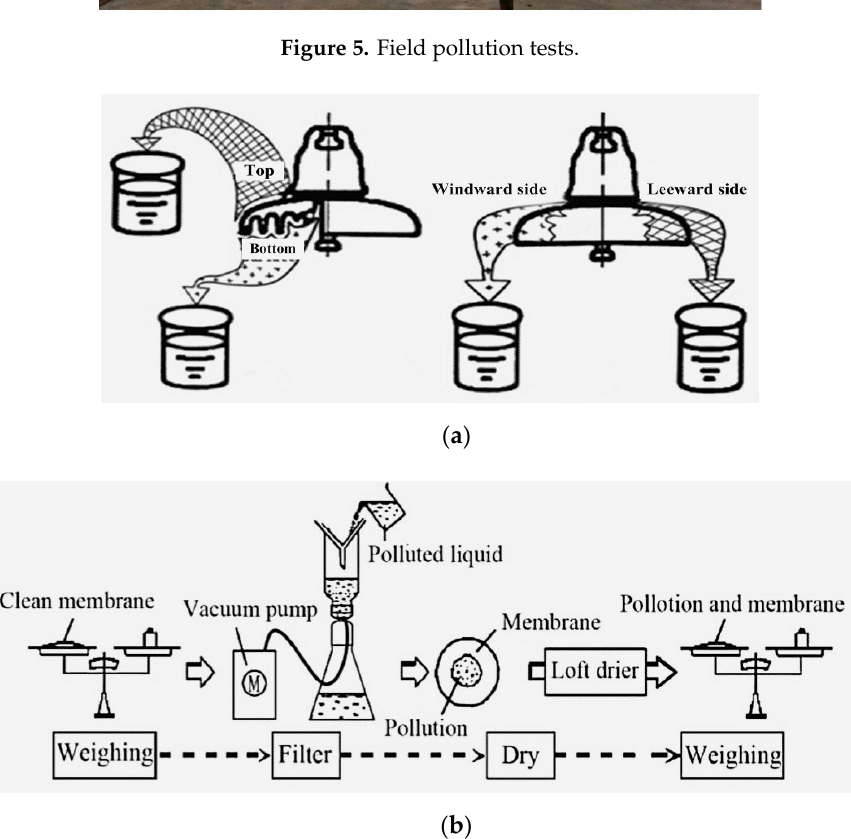
Figure 6. The measuring method of contamination [8]: ( a ) the collection of contamination; and ( b ) the contamination weighing process.